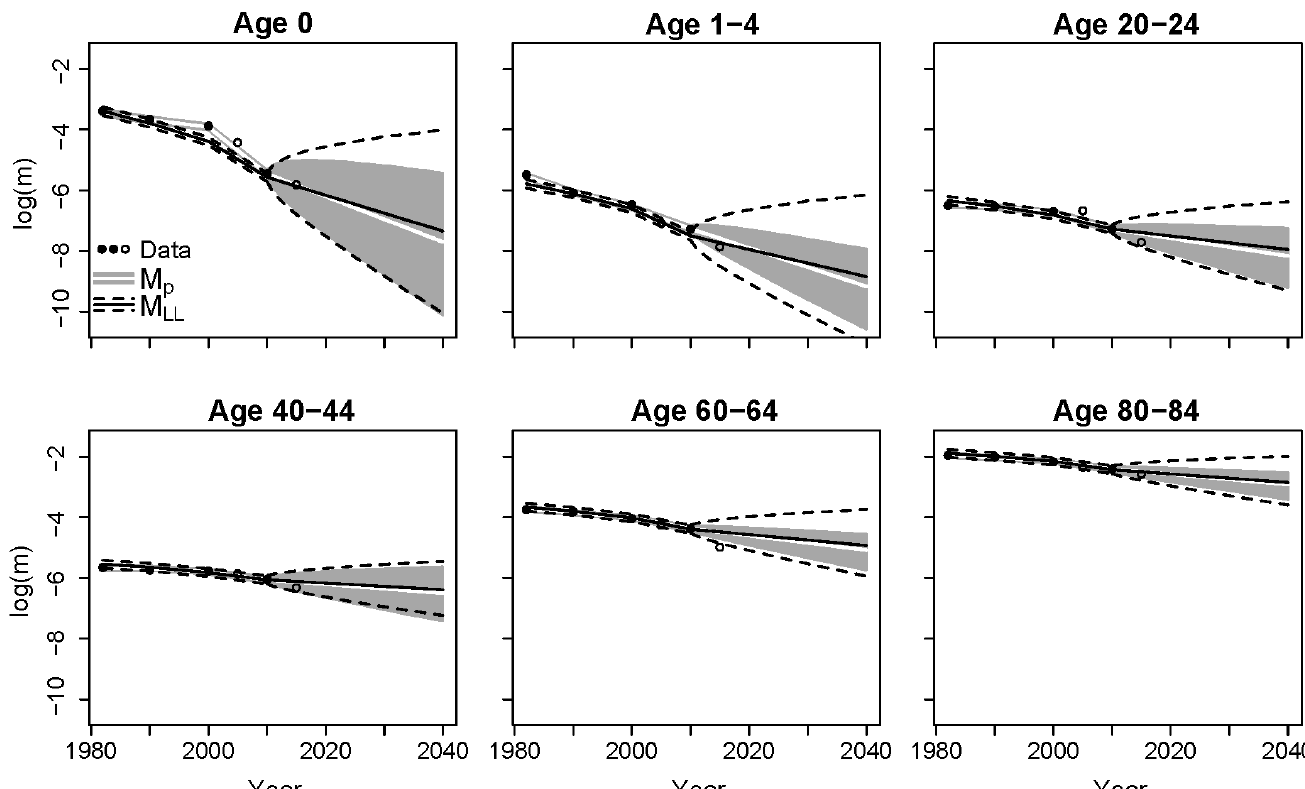
Figure 7. Estimates and forecasts for China.